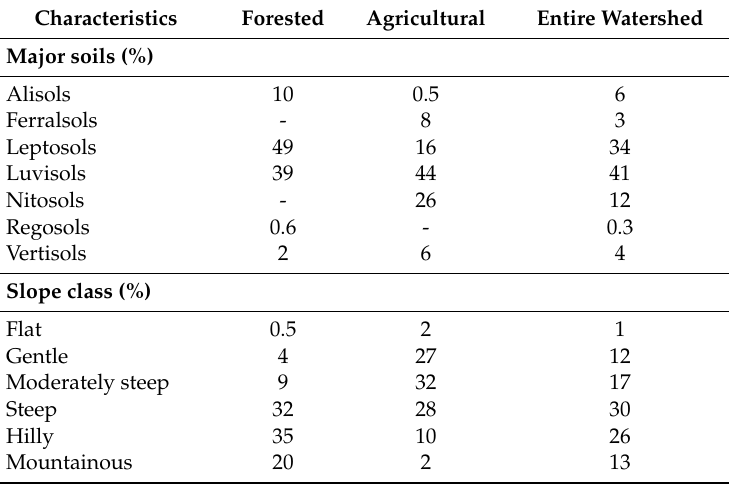
Table A1. Watershed characteristics of the Gomit